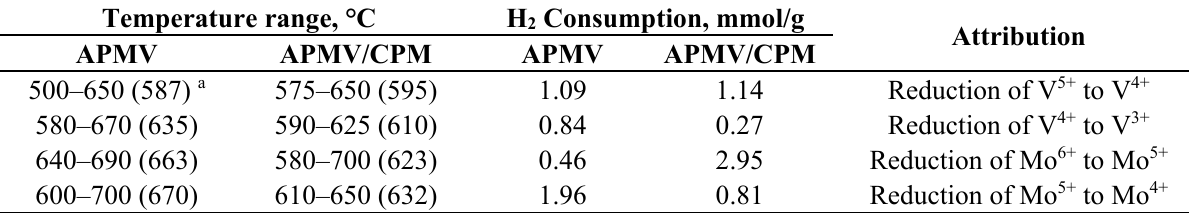
Table 2. Tentative attribution of H 2 -TPR signals for APMV and APMV/CPM.